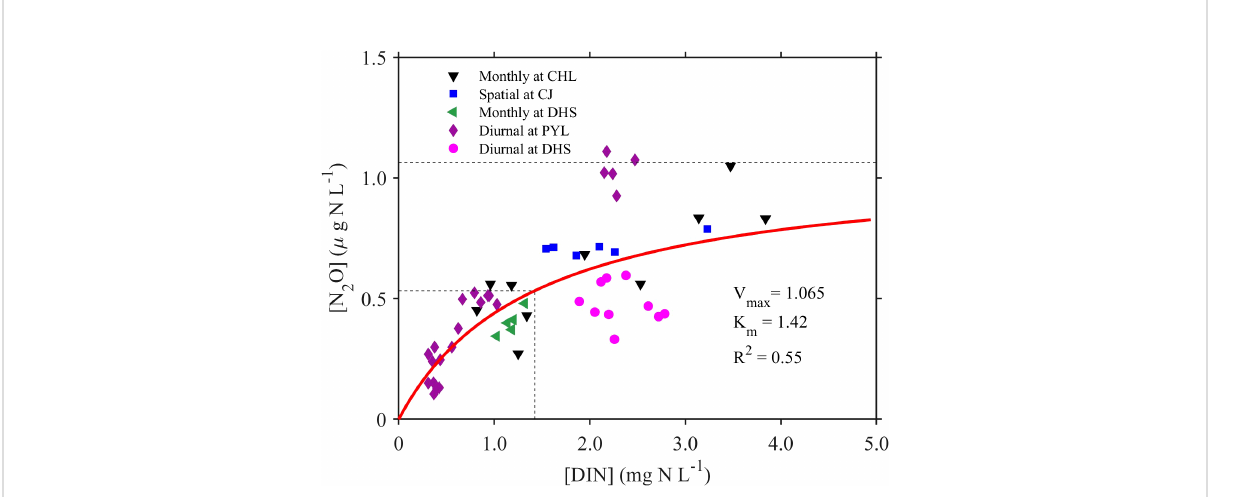
FIGURE 2 Field measurement of N 2 O concentrations as a function of DIN concentrations ( n = 55 ). Red line corresponds to Michaelis – Menten curves. (CH, Chaohu Lake water system, CJ, the Changjiang River, DHS, Datong Hydrological station at the Changjiang River mouth, PYH, Poyang Lake water